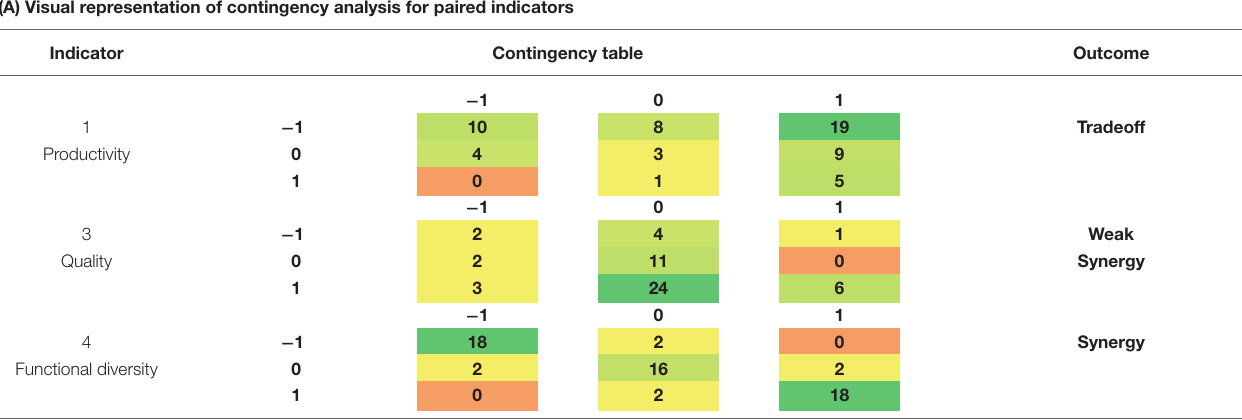
TABLE 4 | Matrices showing relationships between ecological and nutritional indicators for 60 farms in the Guatemalan case study. (A) Visual representation of contingency analysis for paired indicators Indicator Contingency table